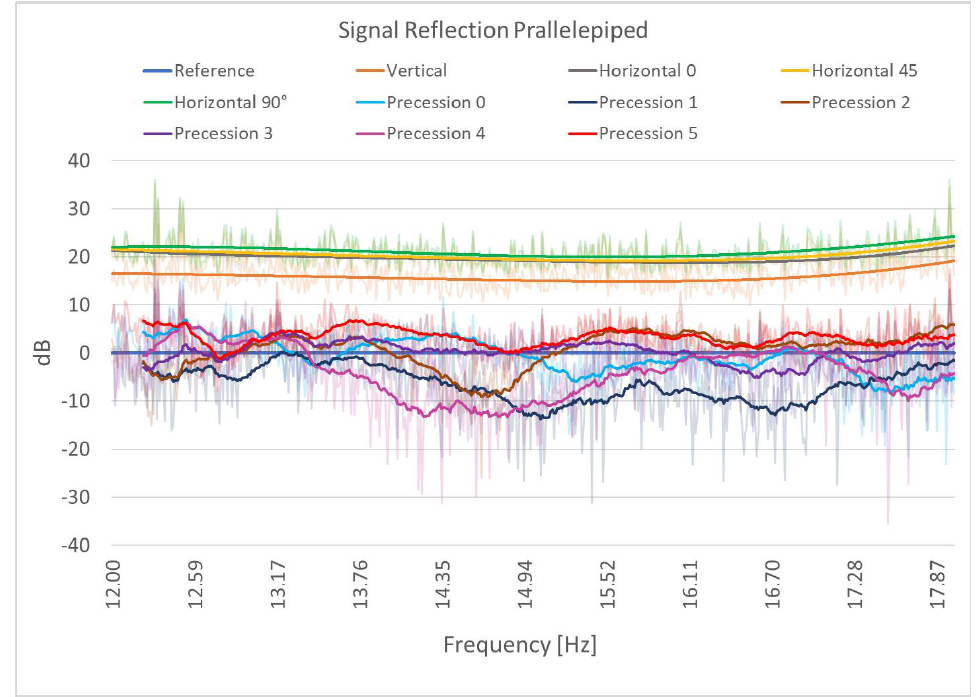
Figure 7. Parallelepiped signal reflection: TE polarization reflection vs. frequency.